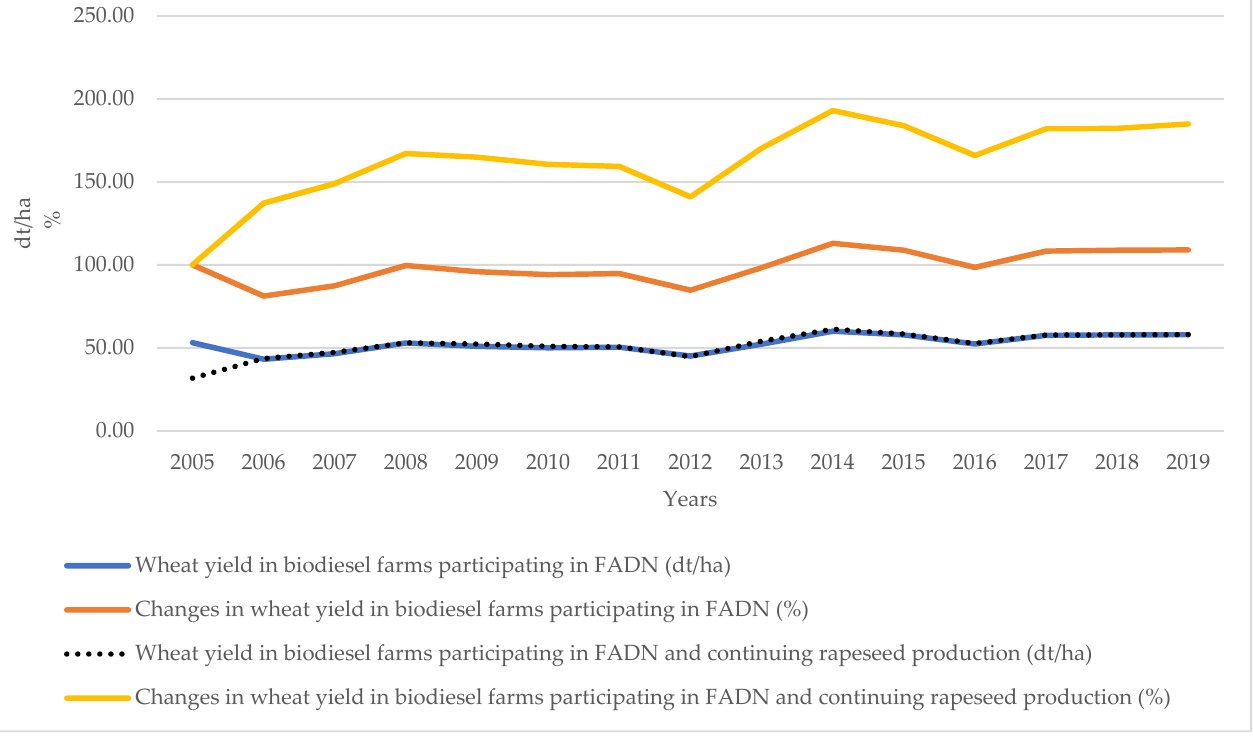
Figure 3. Wheat yields, including fixed-base indices of changes in crop yields, in biodiesel farms participating in the FADN. Source: own elaboration based on FADN data [52].